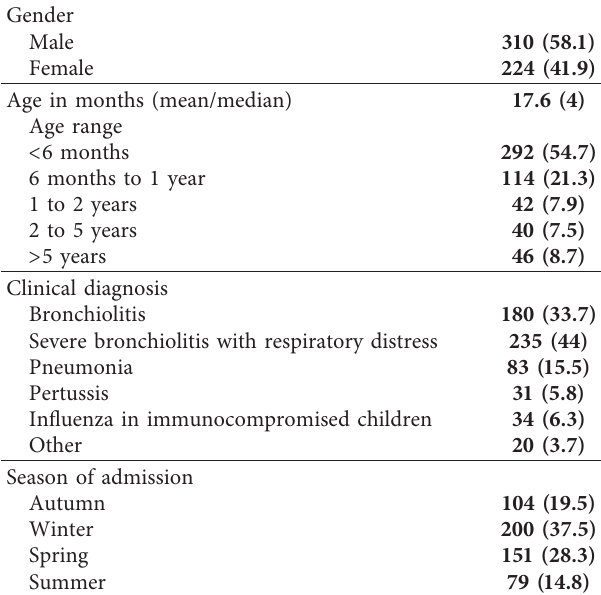
Figure 1: Prevalence of respiratory distress according to age group. Table 1: Paediatric patient demographics and clinical character- istics ( n �